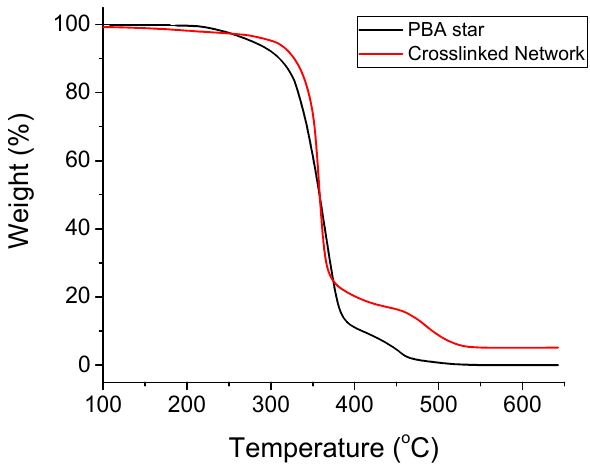
Figure 7. TGA of the star polymer and crosslinked network.